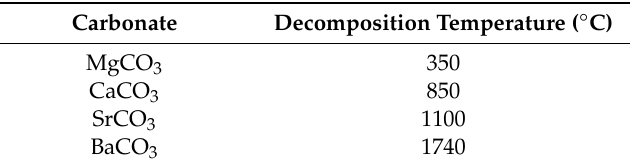
Table 3. Decomposition temperature of carbonates.